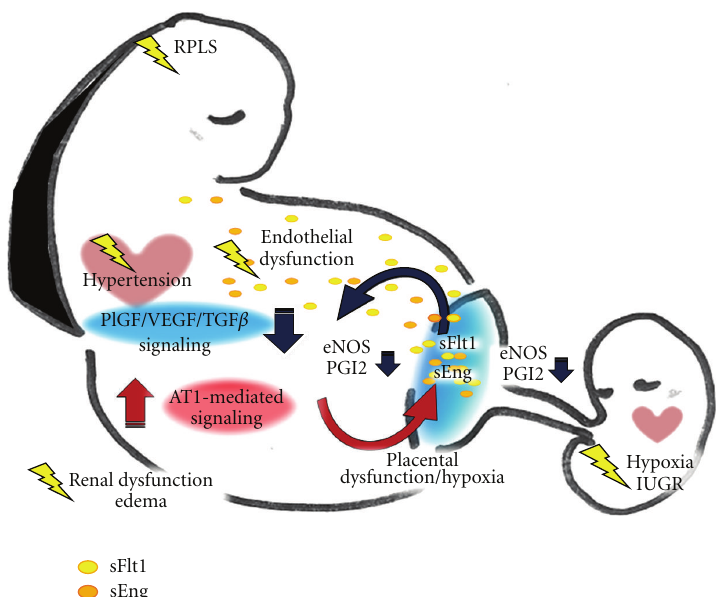
Figure 3: Schema of symptoms and signaling relationship between mother and placenta in preeclampsia. Aberrant AT1-mediated signaling in maternal vasculature and/or shallow invasion of trophoblasts makes the placenta hypoxic. In response, placental villous units produce sFlt1, sEng, and other proinflammatory cytokines that flow into maternal circulation, leading to systemic endothelial dysfunction. The increase of shear stress in fetoplacental site due to maternal hypertension further aggravates the whole